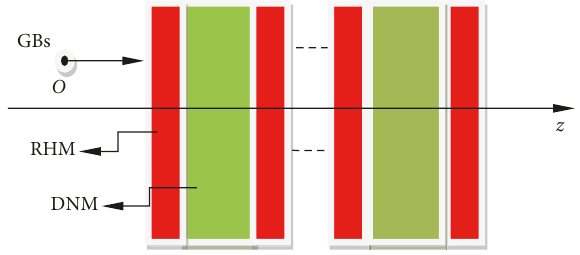
Figure 1: Light path schematic drawing of the sandwich slab system which contained